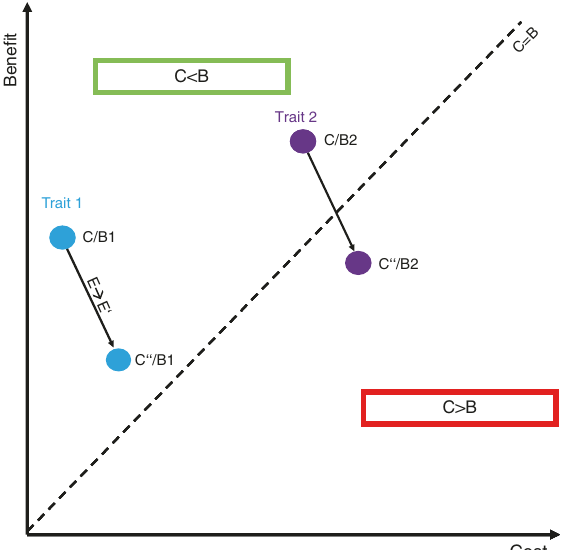
Fig. 2 Environmental changes alter cost-bene fi t ratios. Every trait is characterized by a cost-bene fi t ratio (C/B) that is con fi ned to a given environment. Trait 1 (blue) is a moderate bene fi t, low cost trait (C/ B1), while Trait 2 (purple) exhibits a high cost, high-bene fi t ratio (C/ B2), the latter being sensitive to environmental factors. Upon a given environmental change (E → E ′ ), Trait 1 thus remains adaptive (C <